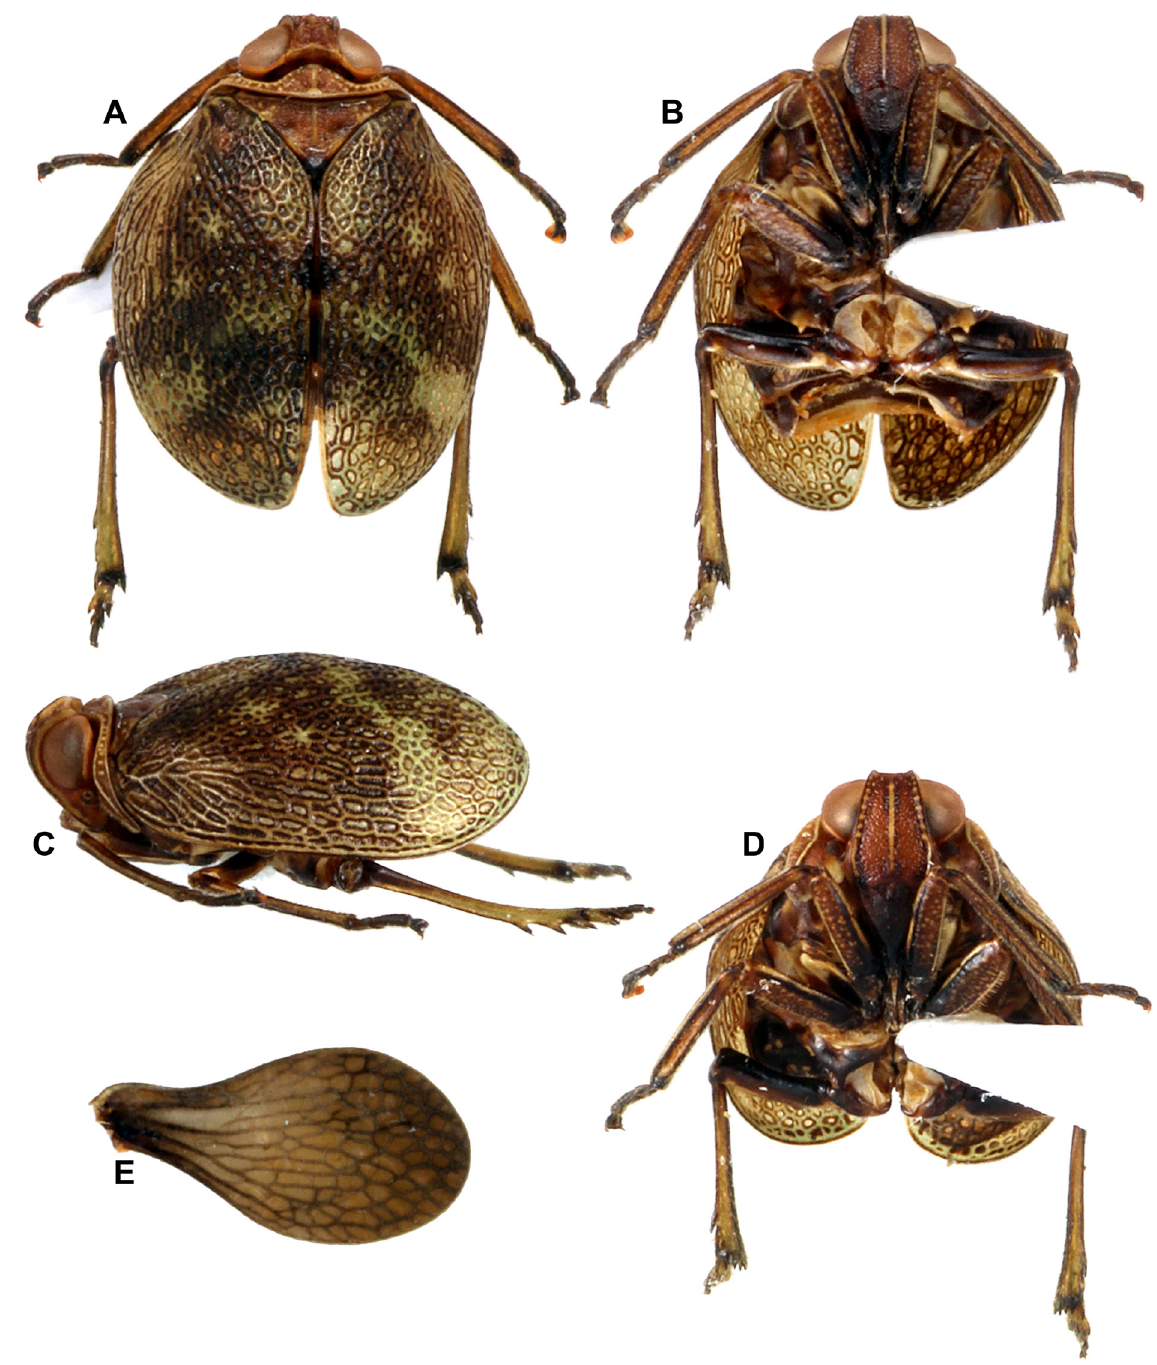
Fig. 3. Gergithoides nui sp. nov., holotype, ♂, total length: 5.3 mm. A . Habitus, dorsal view. B . Habitus, ventral view. C . Habitus, lateral view. D . Habitus, normal view of frons. E . Right